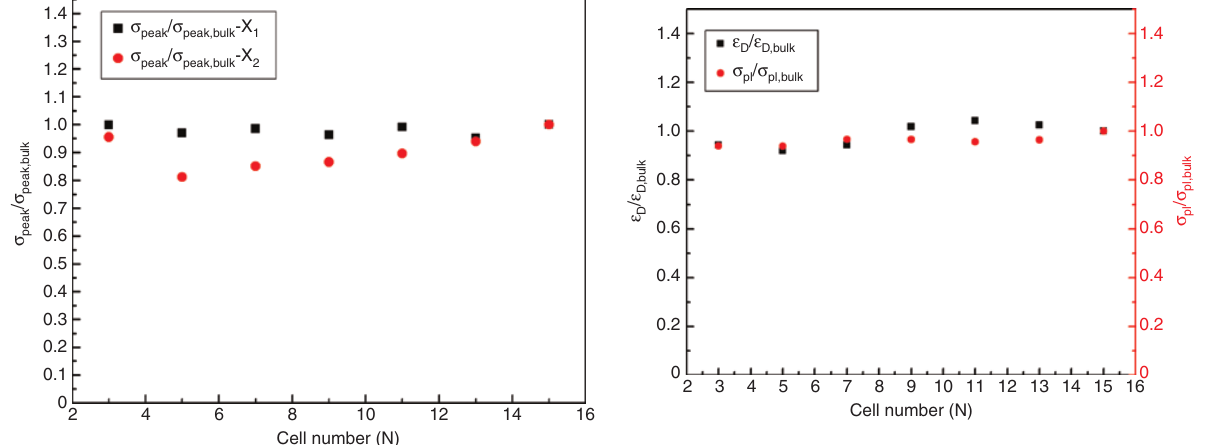
Figure 8 The initial collapse stress of seven kinds of honeycomb specimens with different in-plane size, normalized by the bulk value, plotted against cell number, N .